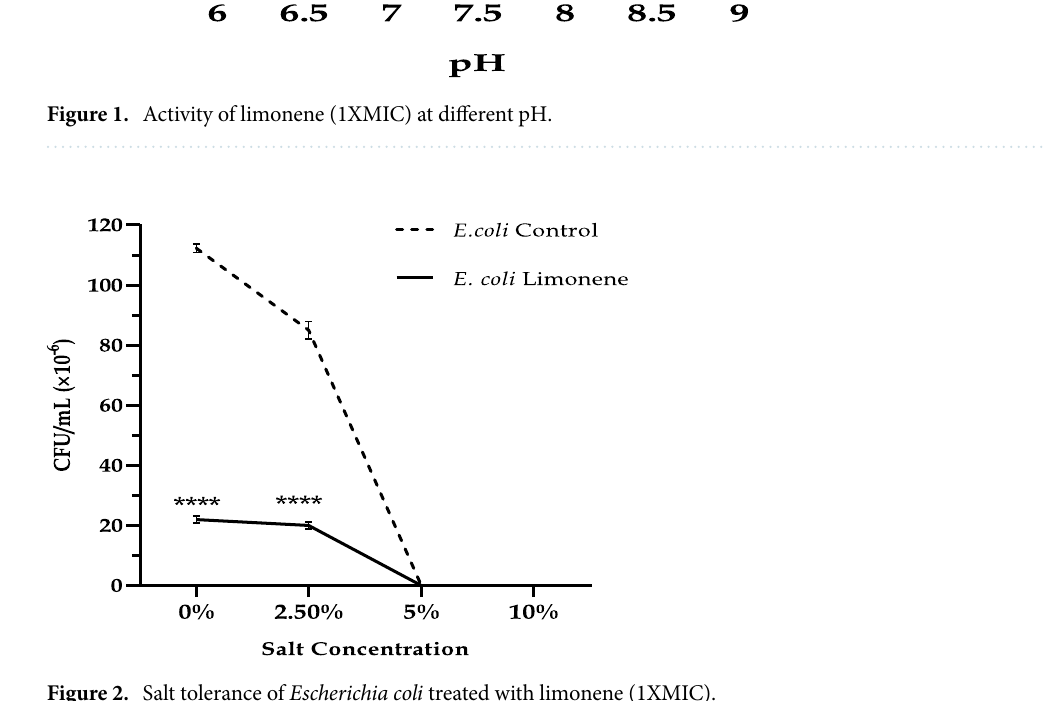
(Fig. 5a). A significant increase in O. D. values due to alteration of outer membrane permeability with respect to entry of nitrocefin inside the E. coli cells treated with limonene as compared to control (P < 0.001). Thus, a dose dependent increase in alteration in outer membrane permeability of E. coli , with increase in time was observed (Fig. 5b). Using ONPG, the permeability of inner membrane was found to be significantly affected in the E. coli cells treated with limonene at 1XMIC and 2X MIC as compared to control (P < 0.0001) (Fig. 5c). Further, a time- dependant membrane depolarization in E. coli cells treated with limonene (@MIC) was observed corresponding to 65.88% RCF within 1 min which further increased to 84.71% after 240 min. (Fig. 5d). With increasing time (0–120 min), exposure of E. coli to limonene showed a proportional increase in the protein leaked in to the medium as evident by the protein bands observed in SDS-PAGE (Fig. 6). An increase in protein leakage cor- responding to 15.67 µg/mL to 35.27 µg/mL and 20.9 µg/mL to 41.89 µg/mL at MIC and twice MIC respectively was recorded (P < 0.001) (Fig. 7a). Similarly, leakage of lipid with values corresponding to 342.55 µg/mL (2XMIC) and 270.21 µg/mL (MIC) was estimated (P < 0.0001) (Fig. 7b). Leakage of 260 nm absorbing cellular material comprising of nucleic acids, metabolites and ions was demonstrated with values ranging between 0.192–0.650 at MIC and 0.529–0.985 at 2XMIC (P < 0.0001) (Fig. 7c). With increasing concentration of limonene from 0.0625